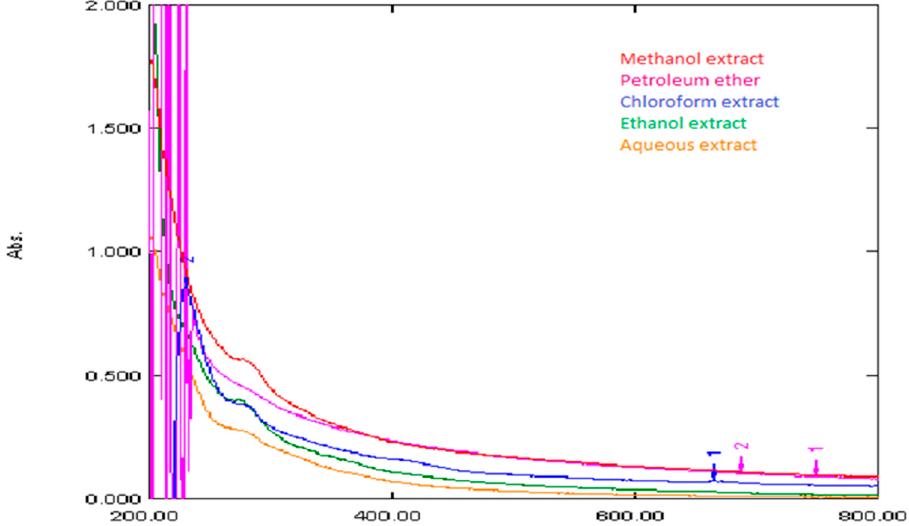
Figure 7. UV-vis spectra of all the extracts of the flower of Bombax ceiba L.